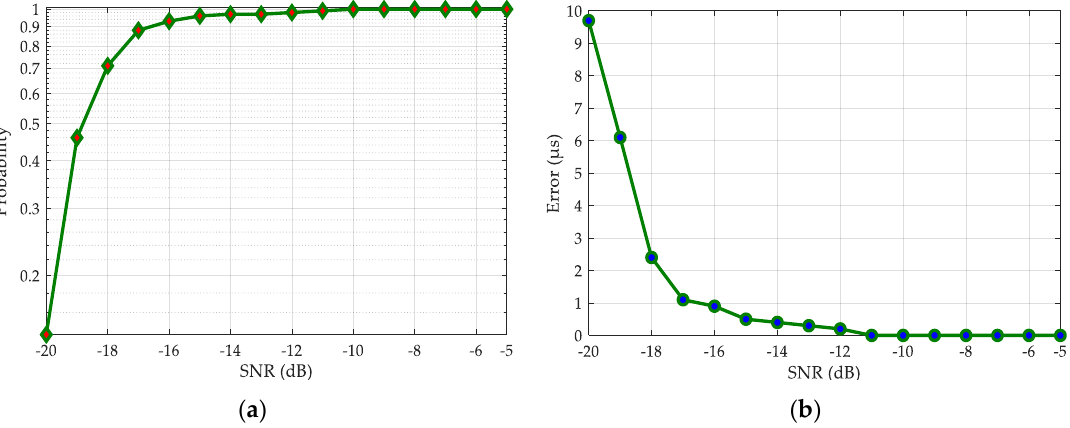
Figure 11. The acquisition performance as a function of SNR: ( a ) acquisition probability; ( b ) Figure acquisition error.